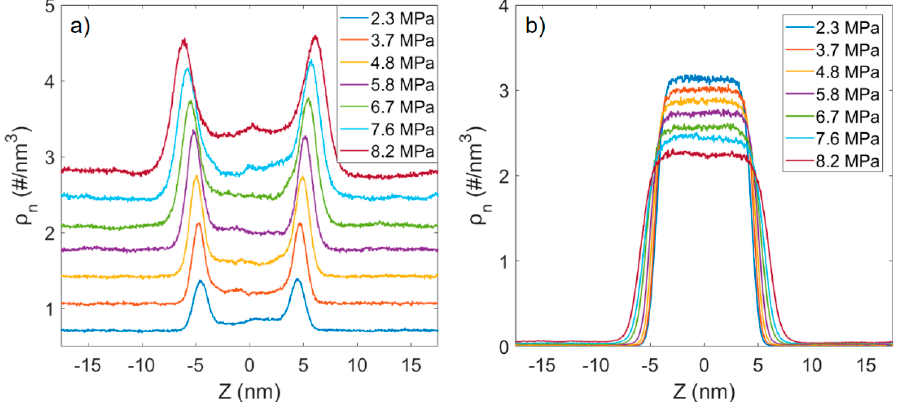
Figure 2. Number density profiles of CO 2 and n -octane system under different pressure. ( a ) CO 2 , ( b ) n -octane. # represents the number of molecules. ( b ) n -octane. # represents the number of